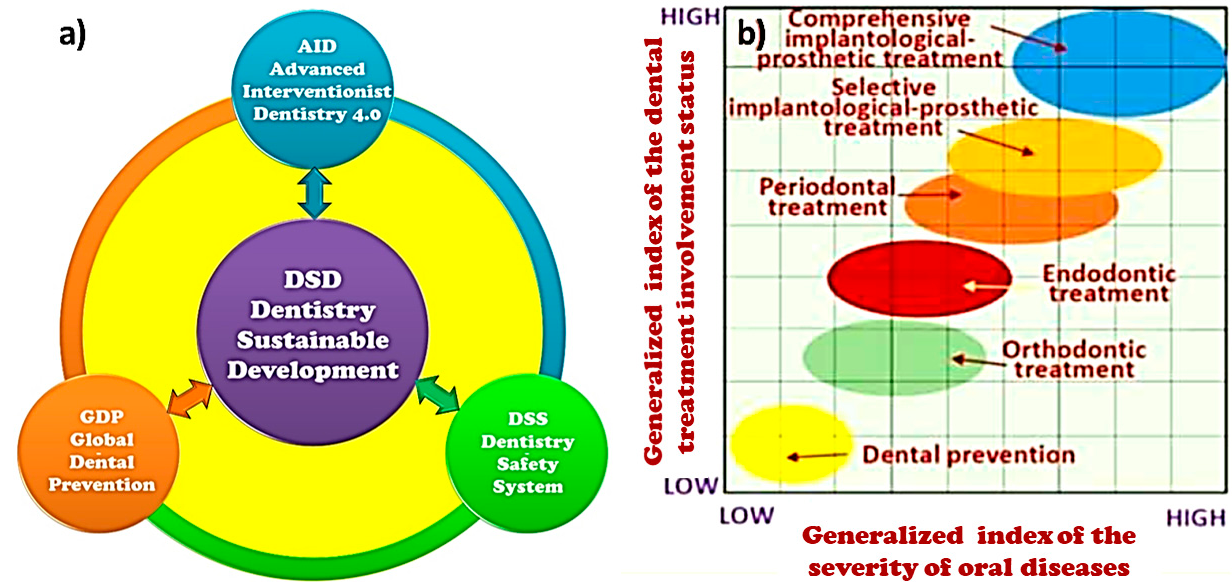
Figure 2. Diagram of the Dentistry Sustainable Development model ( a ), and an original concept of the matrix of advancement and treatment of oral diseases with the place of endodontics ( b ).